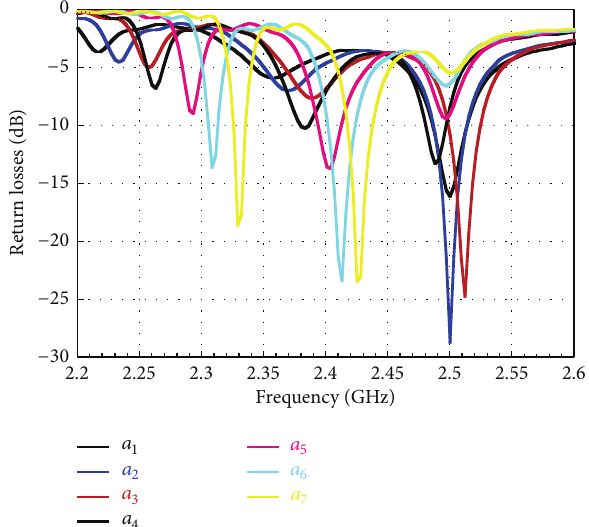
Figure 2: Return losses (open load line analysis).